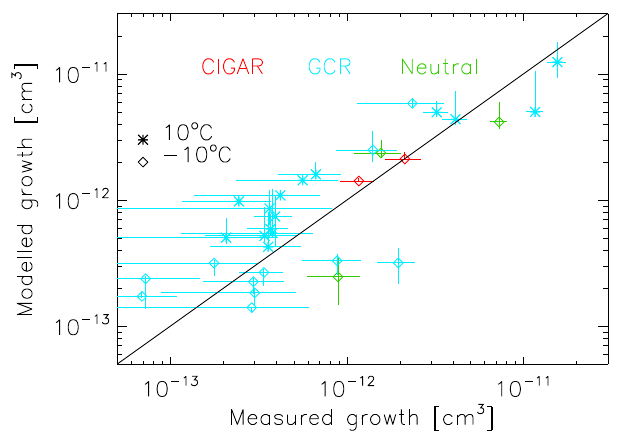
Figure 12. As for Fig. 11a, except that the colours indicate the ion conditions under which the experiments were performed: ion free (neutral), natural ion concentrations (GCR) and enhanced ion con- centrations